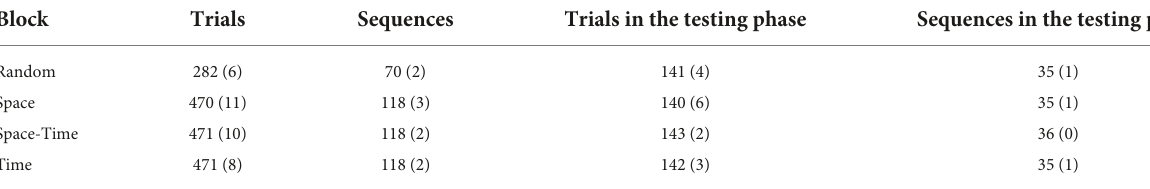
TABLE 1 Average number of trials and sequences plotted per participant in each big block, presented separately for the whole task and for the “testing” phase.